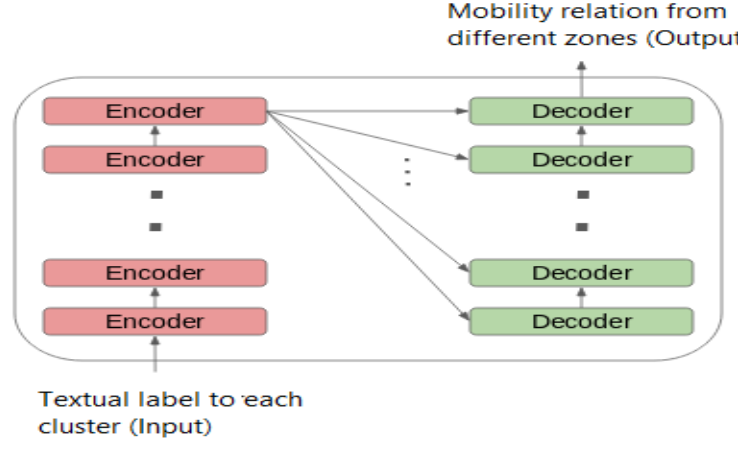
Figure 4. Encoder and decoder associations with cluster